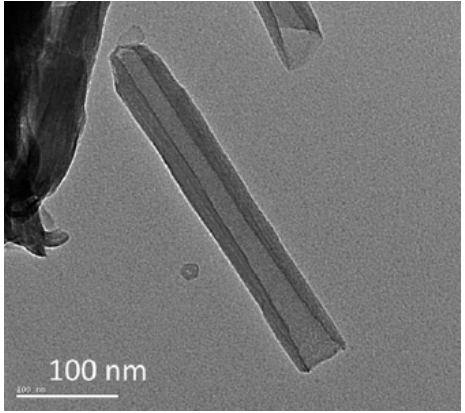
Figure 3. TEM micrograph of HNTs [44].